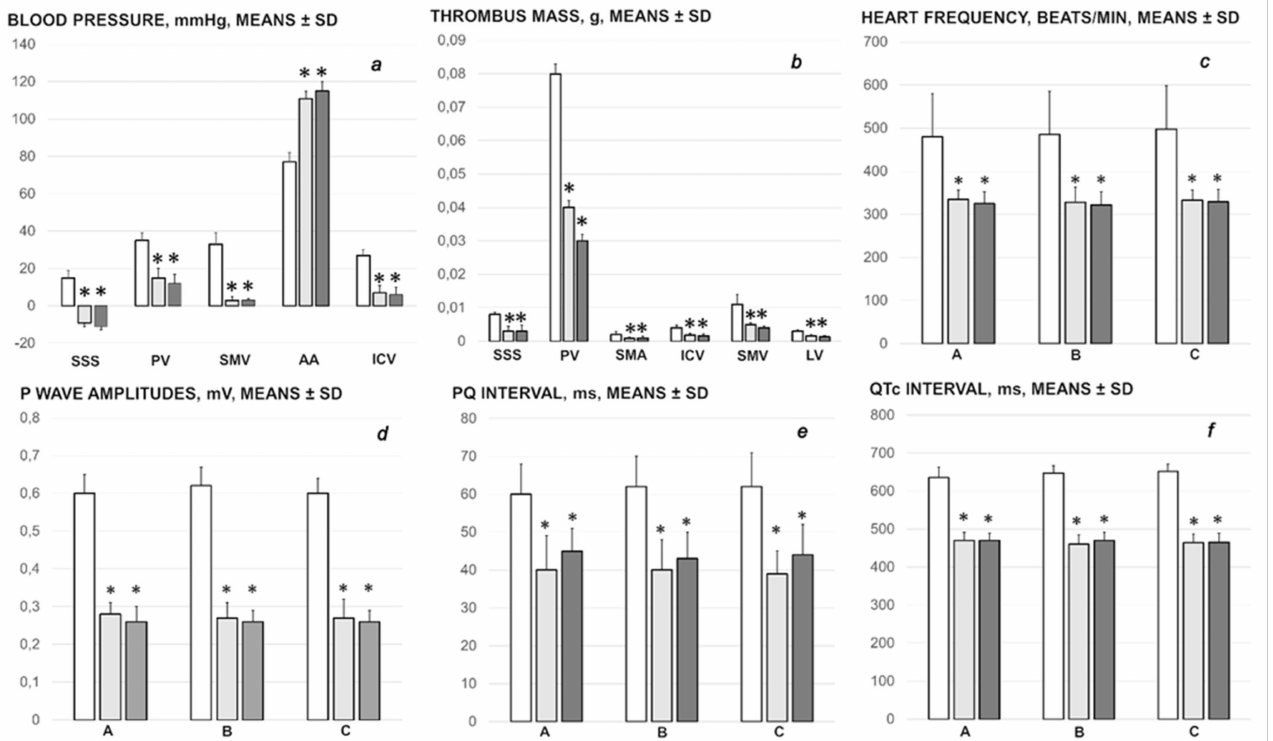
Figure 1. Blood pressure ( a ) and thrombus ( b ) presentation in the rats with the irremovable occlusion of the superior mesenteric vein (superior sagittal sinus (SSS), portal vein (PV), abdominal aorta (AA), inferior caval vein (ICV), superior mesenteric vein (SMV) and lienal vein (LV)). Assessment at the end of the 30 min ligation period. BPC 157 10 µ g/kg (light gray bars), 10 ng/kg (dark gray bars); saline 5 mL/kg (white bars) given intraperitoneally at 1 min ligation time. ECG changes ( c – f ) at 5 min (A), 15 min (B) and 30 min (C) ligation time. Six rats/group/interval. Means ± SD, * p < 0.05, at least, vs.